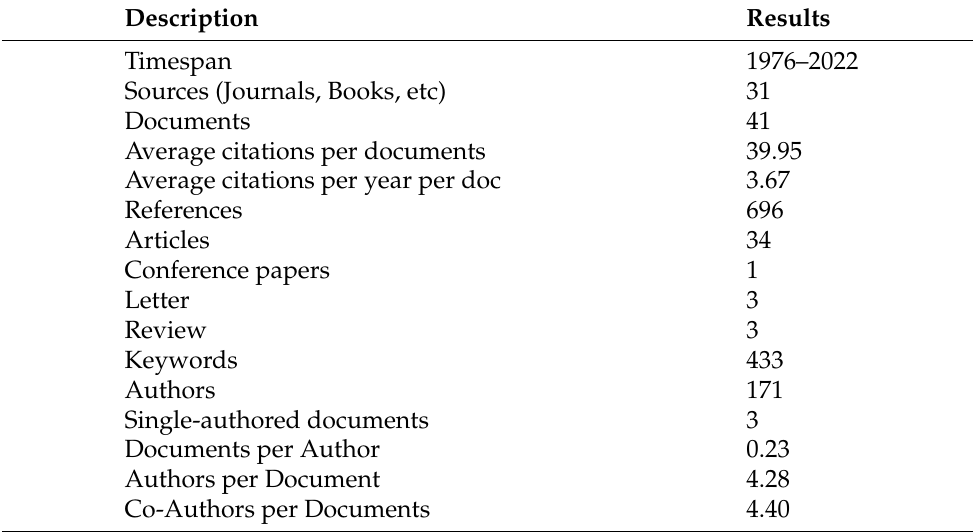
Table 2. Main information about selected